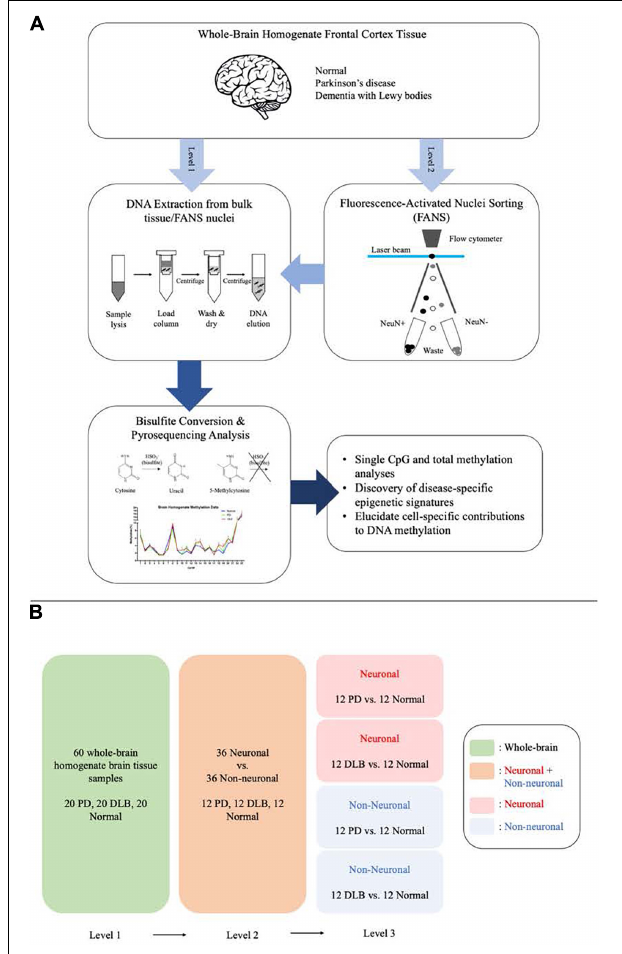
FIGURE 1 | Schematic presentation of the study workflow and comparisons. (A) The study workflow. (B) The comparison